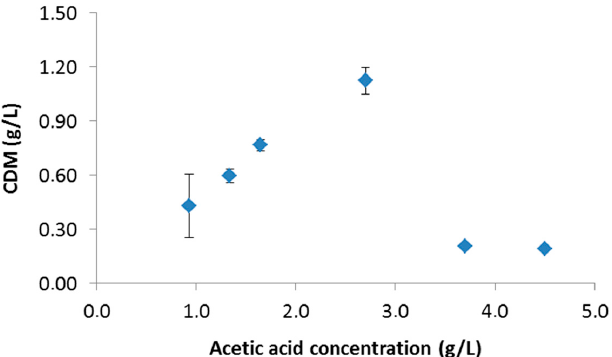
Figure 1. Effect of the initial acetic acid concentration on the cell growth of C. necator in shake flask after 24 h of incubation. Results are shown as average ± standard